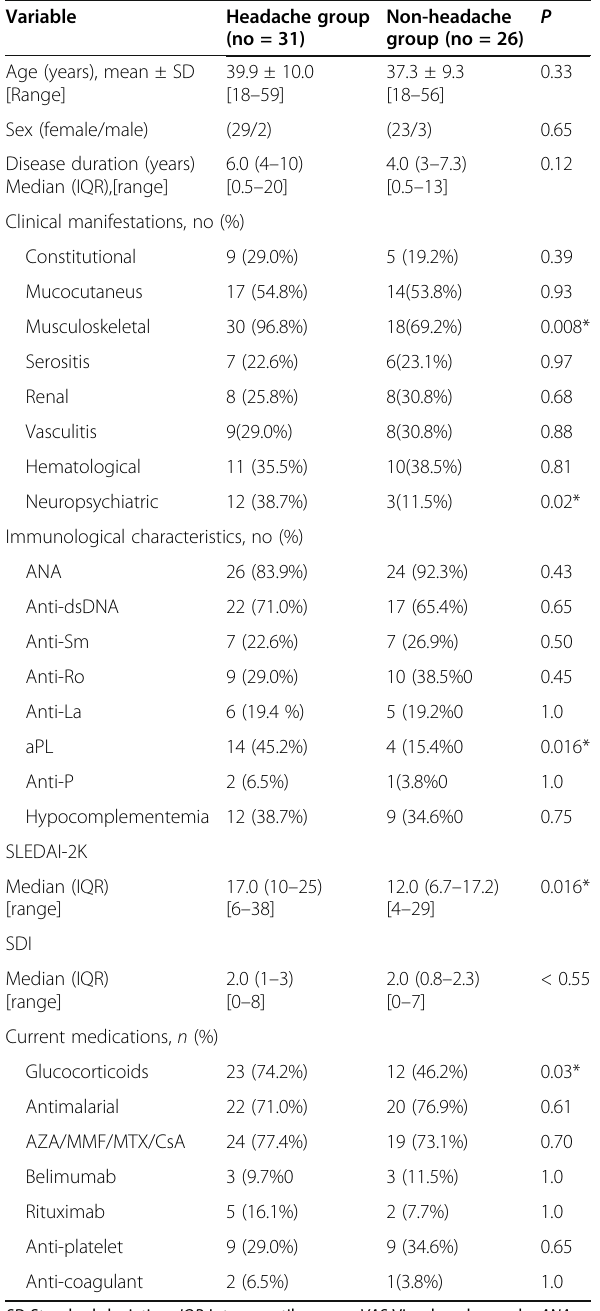
Table 2 Demographics, disease-related variables, and current medications in the headache and non-headache groups